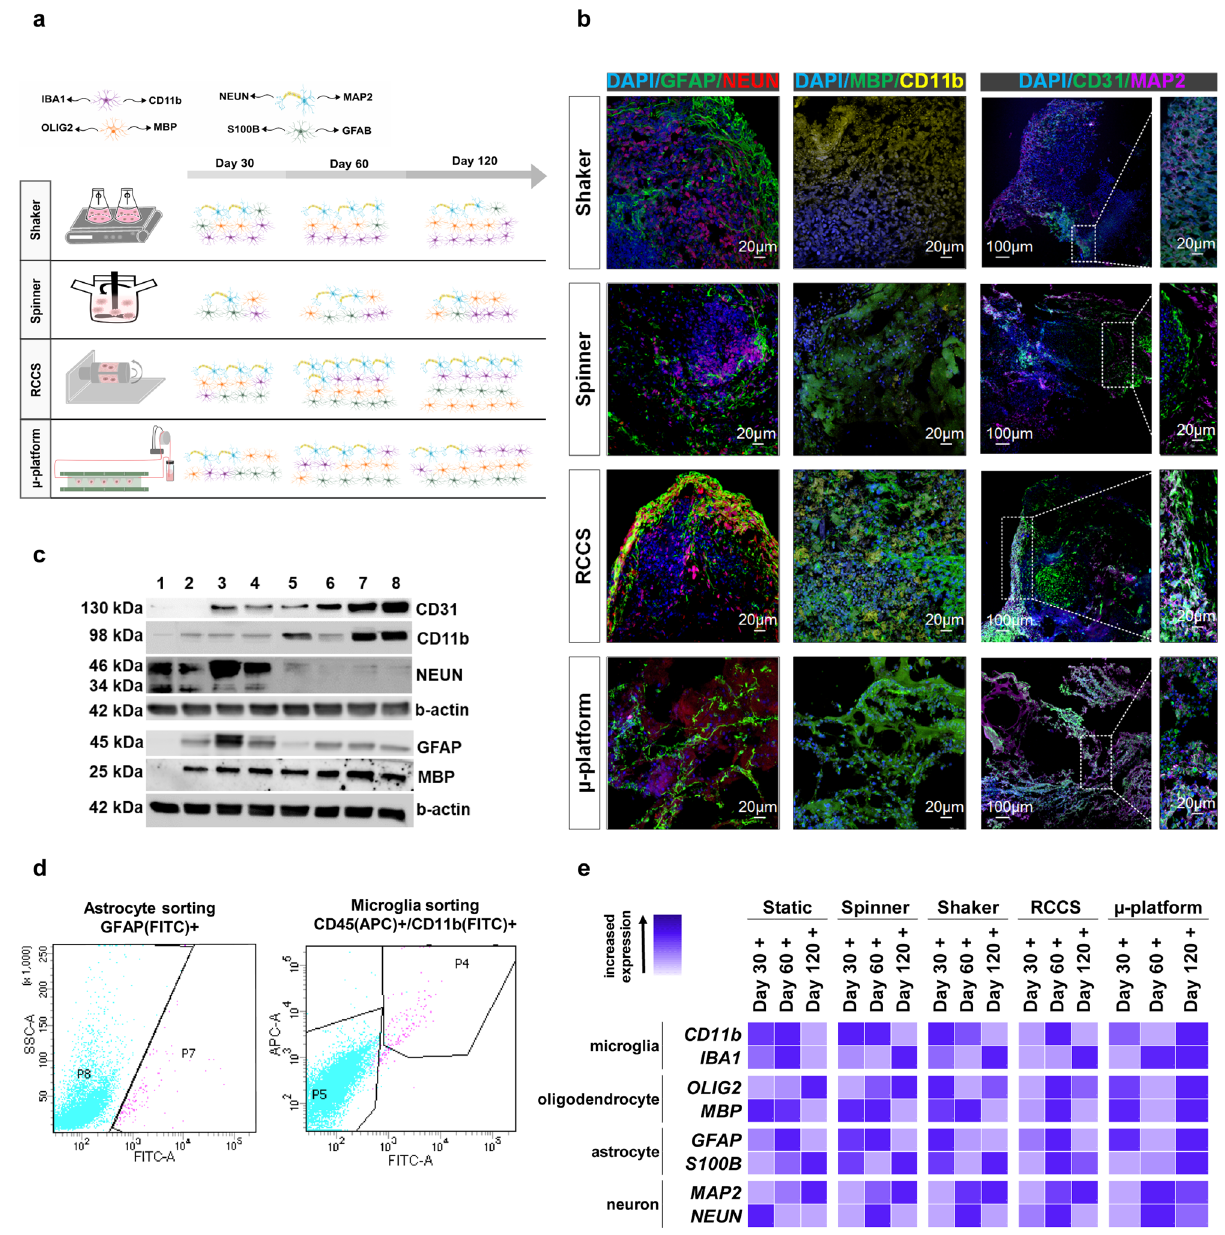
Fig. 3 Cellular diversity of cerebral organoids. a A schematic illustration of cell diversity of cerebral organoids matured in dynamic systems. b Immuno fl uorescence staining of speci fi c neuronal/glial/endothelial cell markers (NEUN/GFAP, MBP/CD11b, CD31/MAP2) at 120 days of organoids matured in 4 dynamic systems (scale bars = 100 μ m for 10× and 20 μ m for 25× magni fi cation images, independent replicates = 3, Zeiss LSM 880). c WB analysis for neuronal proteins of cerebral organoids matured in a shaker (1,5), spinner (2,6), RCCS (3,7), and µ -platform (4,8) at day 60 and 120, respectively (independent replicates = 2). d FACS analysis of microglia and astrocytes in RCCS organoids on day 60 (independent replicates = 2). e Heatmap data of the qRT-PCR analysis of cerebral organoids matured in static, spinner, shaker, RCCS, and µ -platform on day 30, day 60, and day 120 in comparison to generated organoids on day 15 (independent replicates =